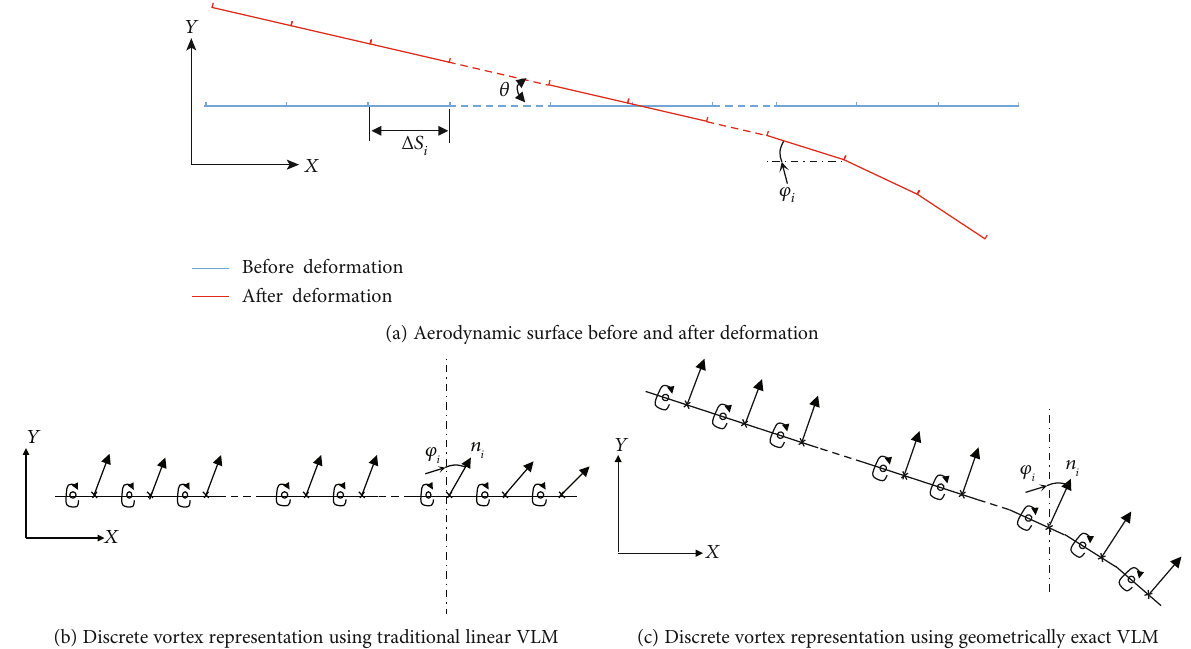
Figure 2: The di ff erent discrete vortex representations using di ff erent